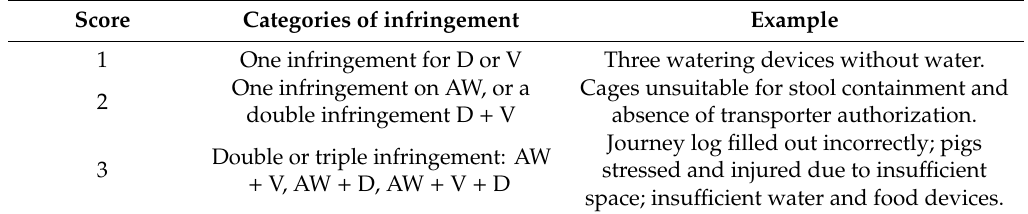
Table 2. Animal welfare-related infringement severity